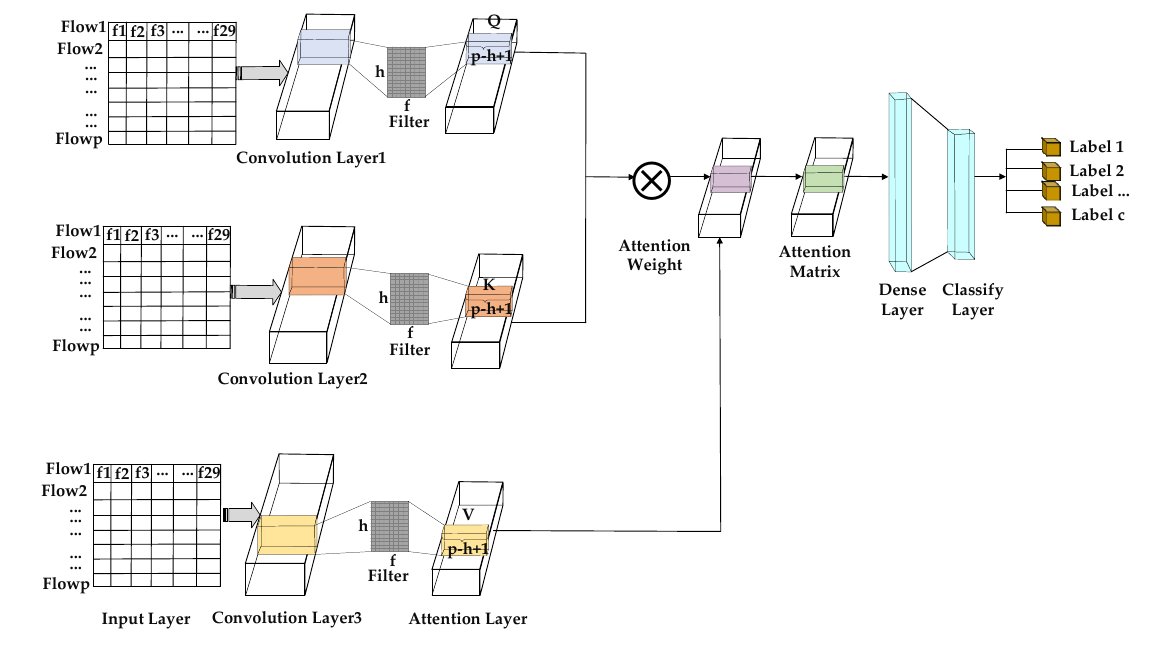
Figure 2. CNN-attention model. Attention layer: The attention mechanism can encode the sequence packet header and payload feature, and assign a weight to each feature determined by the feature simi- larity between the corresponding two locations.